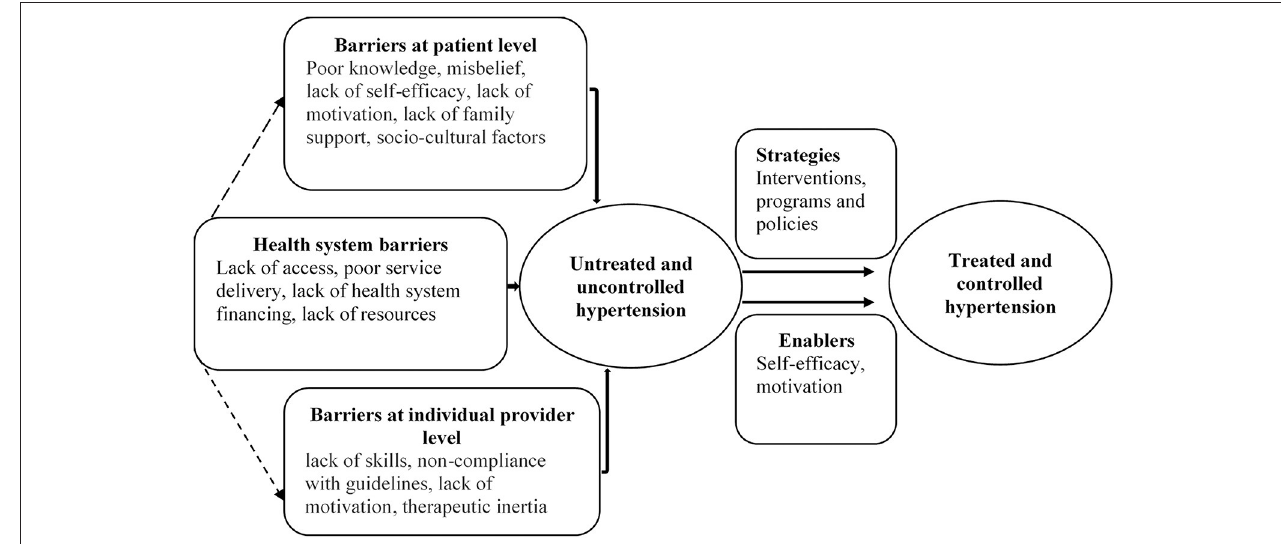
FIGURE 1 | Conceptual framework of barriers, enablers, and strategies for hypertension